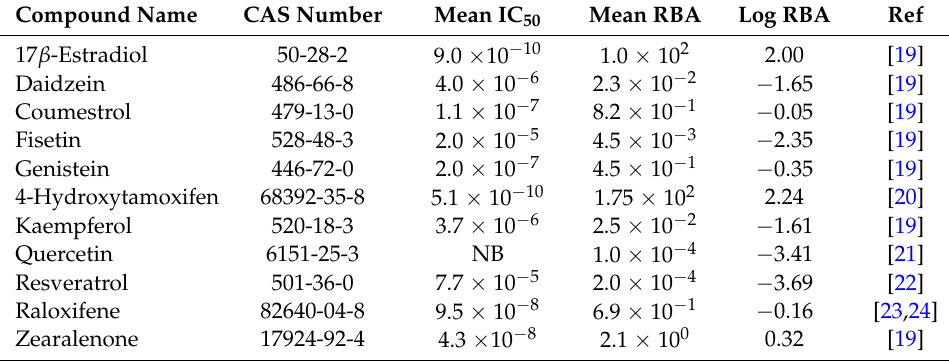
Table 1. Comparison of the binding affinity of various phytoestrogen and mycoestrogens to estrogen